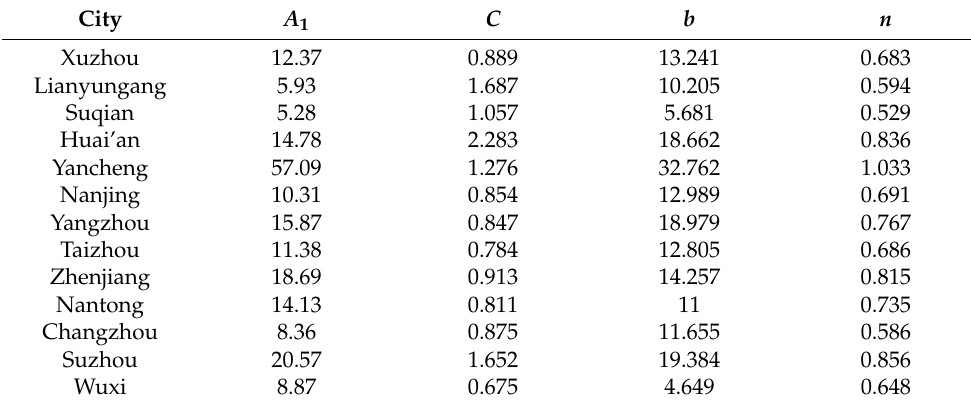
Table 1. Revised parameters of rainstorm intensity formula in 13 cities.